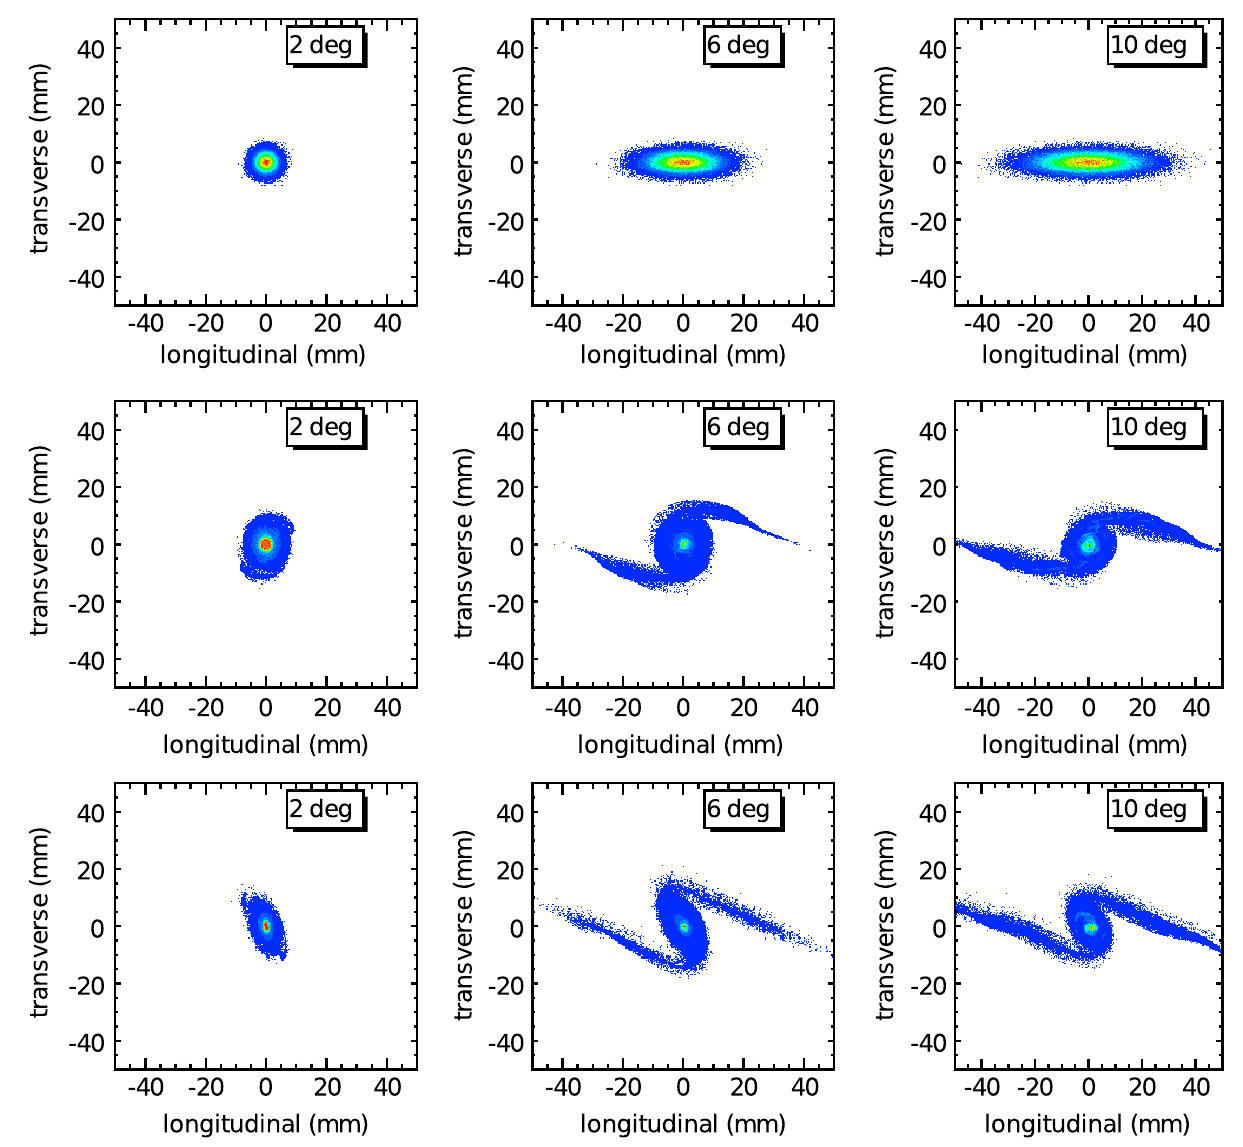
FIG. 9. (Color) Top view of 3 mA bunch distributions with 2 (cid:6) , 6 (cid:6) , and 10 (cid:6) initial phase widths at the initial position (top), turn 50 of the 112 (cid:6) azimuthal position of the PSI ring (middle), and 150 (bottom) in the local frame S local